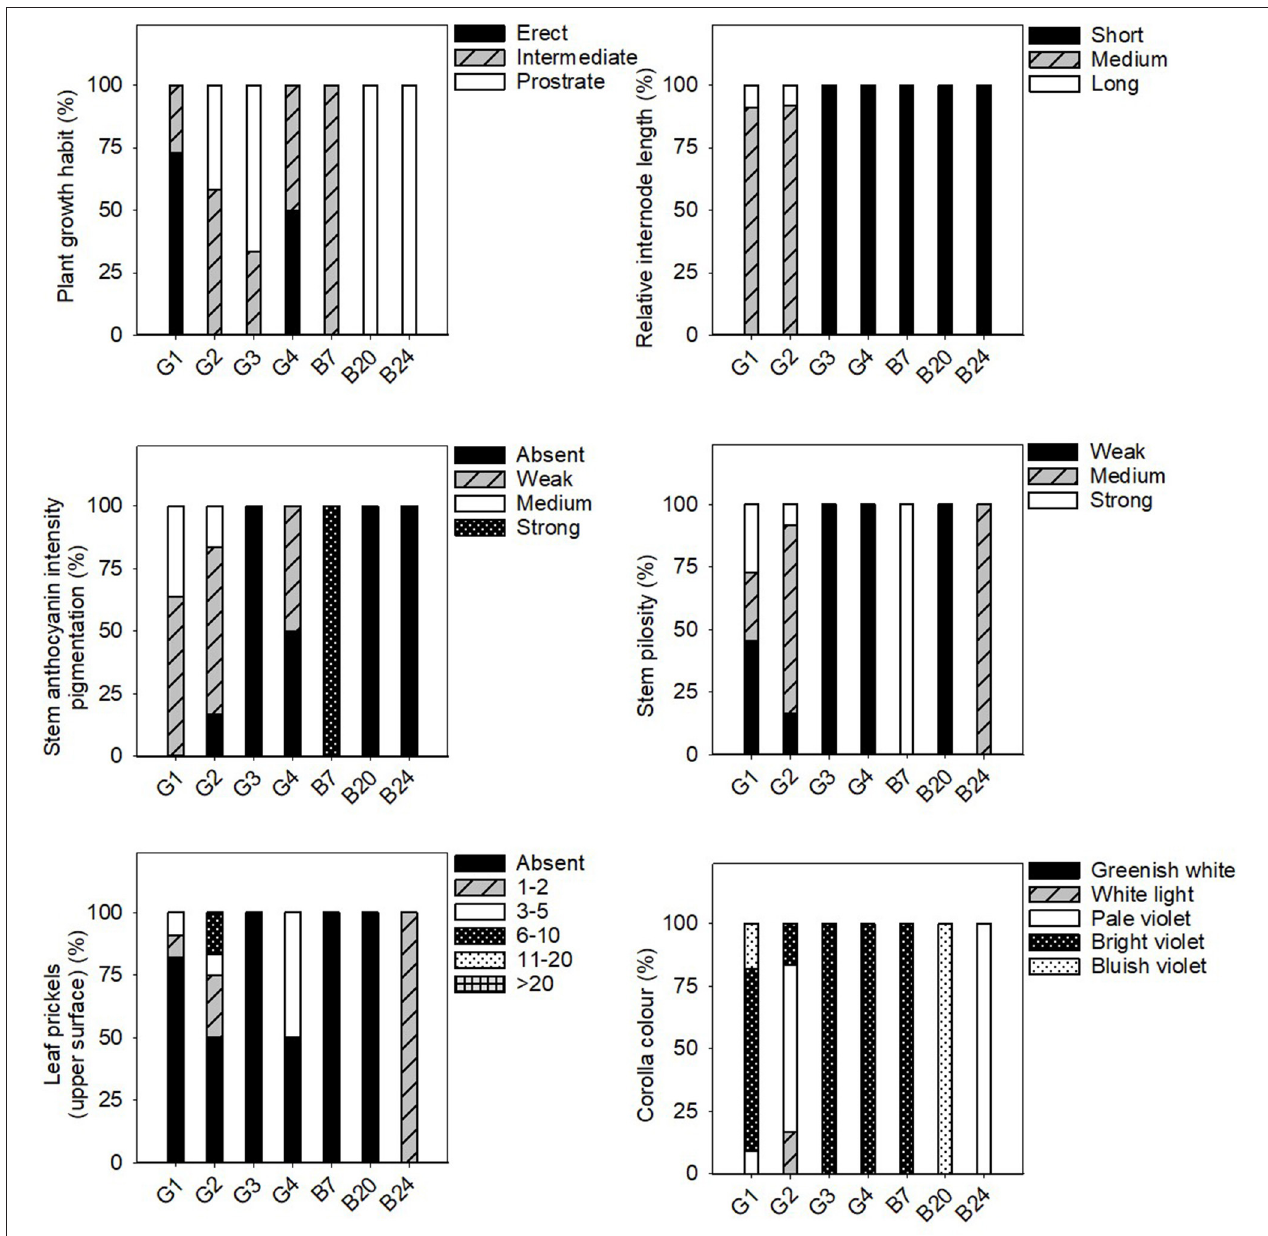
FIGURE 3 | Frequency distribution (%) of the stem, leaf and flower qualitative traits in the 31 eggplant landraces in each group (G1, G2, G3, G4) and B7, B20, and B24. Measurements were taken when fruits reached the commercial maturity. Data for plant, leaf and flower traits were measured from eight independent plants, which gave 8 replicates per